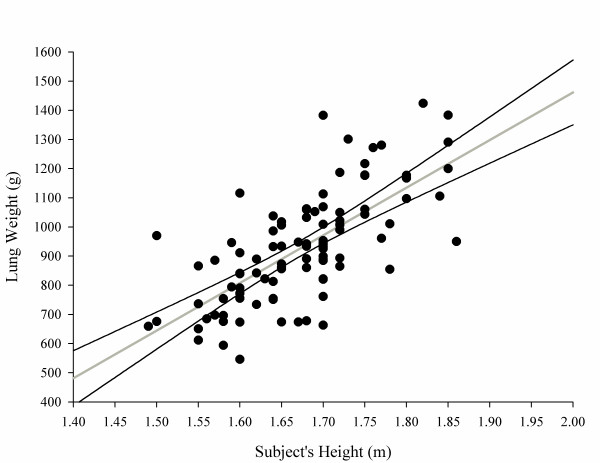
Lung weight as a function of subject height. Lung weight (g) = -1,806.1 + 1,633.7 × subject's height (m). The 2.5 to 97.5% confidence interval for intercept = -2,364.67 to -1,247.63; 2.5 to 97.5% confidence interval for slope = 1,300.53 to 1,966.93; P <0.0001, r2 = 0.49.